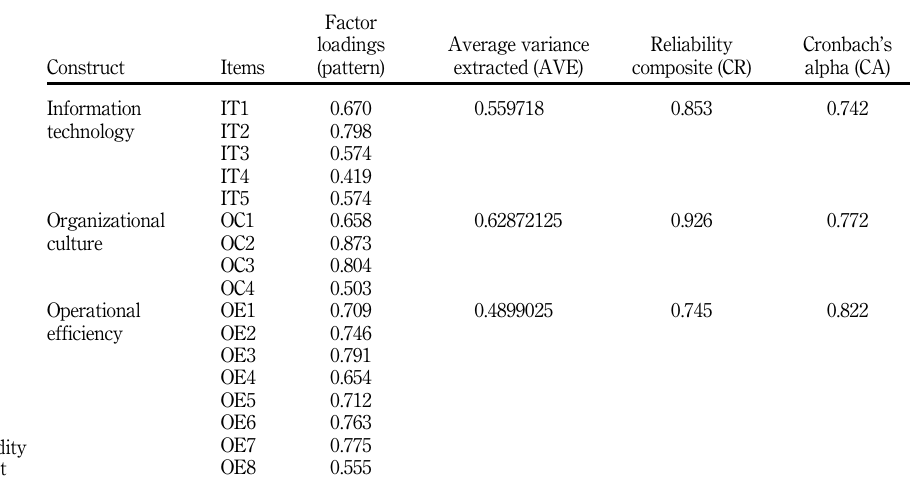
reliability and validity of the